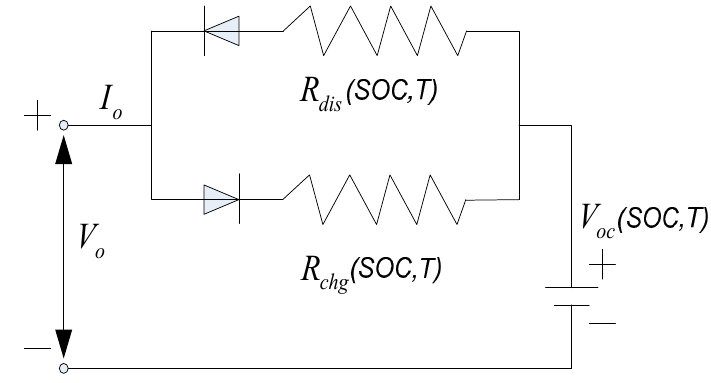
Figure 7. Battery equivalent circuit of the Rint model.